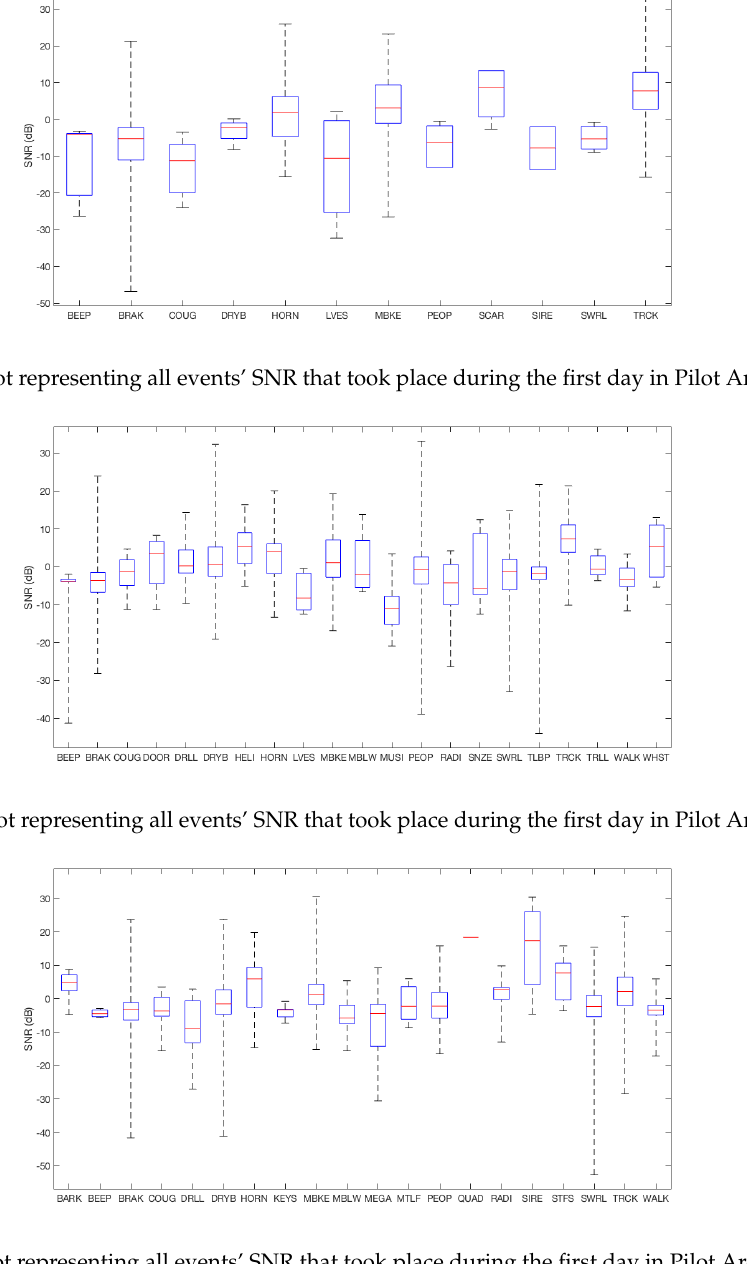
Figure 8. Boxplots representing all events’ SNR that took place during Day 1 in each of three recorded pilot